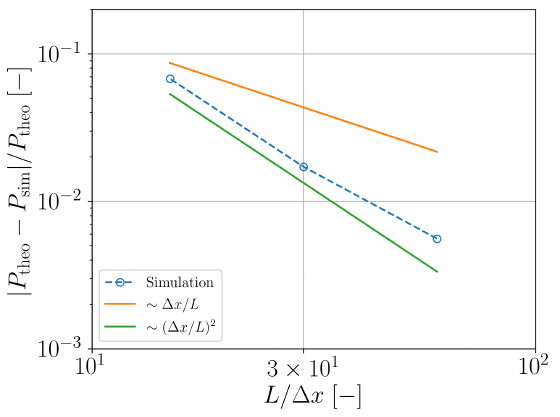
Figure 7. Relative error of the numerically predicted pressure in the droplet as a function of the spatial resolution.